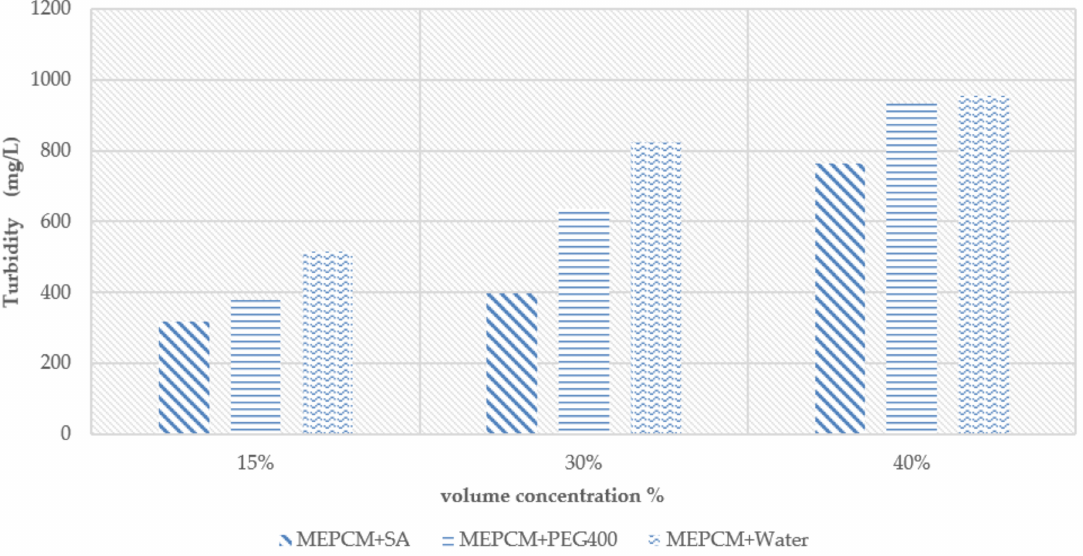
Figure 14. The turbidity values of MEPCMs mixed with SA, PEG 400 and